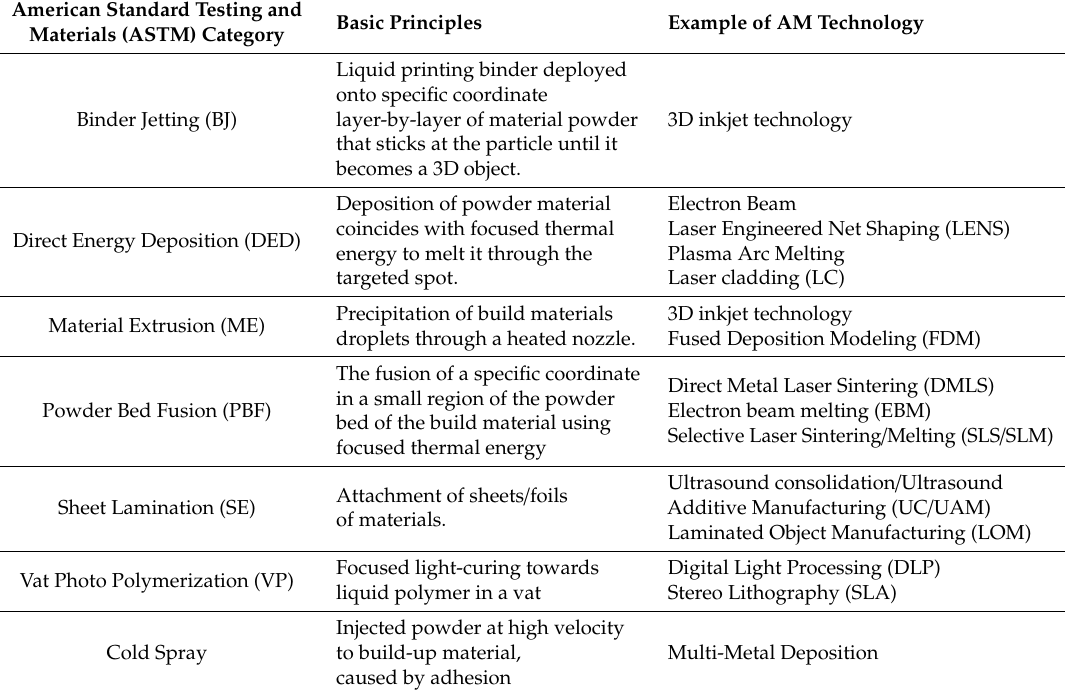
Table 2. Additive Manufacturing (AM) Table 2 . Additive Manufacturing (AM) principles.